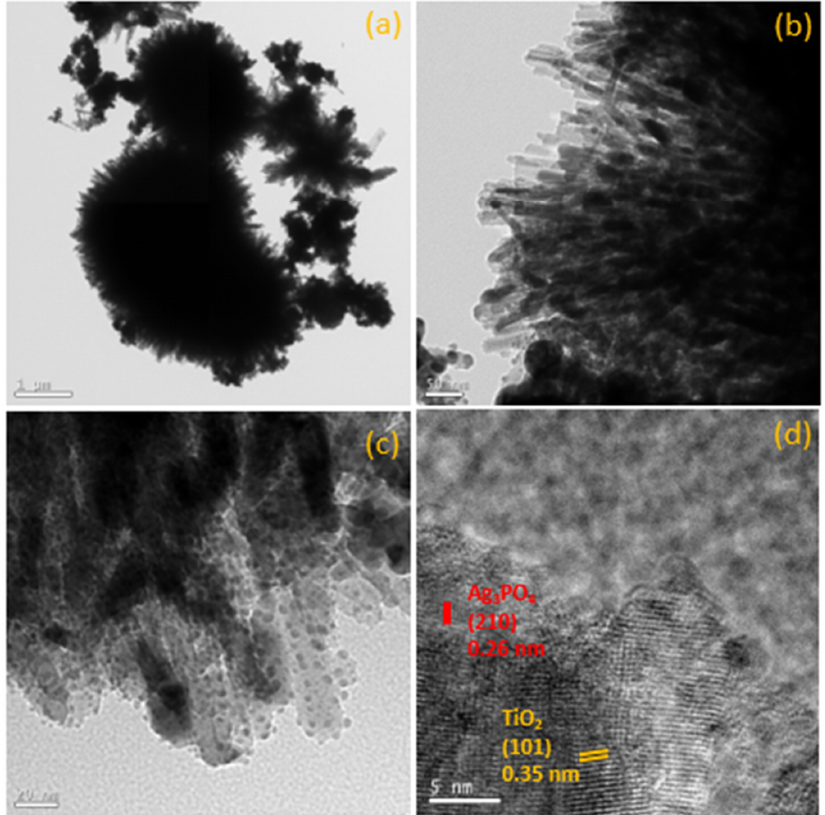
Figure 3. ( a – c ) TEM images of Ag 3 PO 4 /TiO 2 @Ti 3 C 2 (sample A4) viewed under different magnifica- tions. ( d ) HR-TEM lattice image of Ag 3 PO 4 /TiO 2 @Ti 3 C 2 . Figure 4 depicts the scanning TEM (STEM) image of Ag 3 PO 4 /TiO 2 @Ti 3 C 2 with ele- mental mapping. The high-angle annular dark-field (HAADF) STEM image of Ag 3 PO 4 /TiO 2 @Ti 3 C 2 shows areas with different contrasts, with the brighter regions repre- senting Ag 3 PO 4 particles and the darker regions representing TiO 2 @Ti 3 C 2 rods. The ele- mental mapping analysis displays C, O, P, K, and Ag elements from an arbitrary area. In detail, the Ti signal is primarily associated with the backbone of TiO 2 @Ti 3 C 2 , whereas the P and Ag signals are associated with the large agglomerated Ag 3 PO 4 fragments on top of the flower and Ag 3 PO 4 NPs decorated alongside the petals. Additionally, the O signals are distributed uniformly throughout the composite. The elemental mapping results provide more comprehensive and clear observations of the elemental distribution across the whole composite, corresponding to the SEM and HR-TEM above.